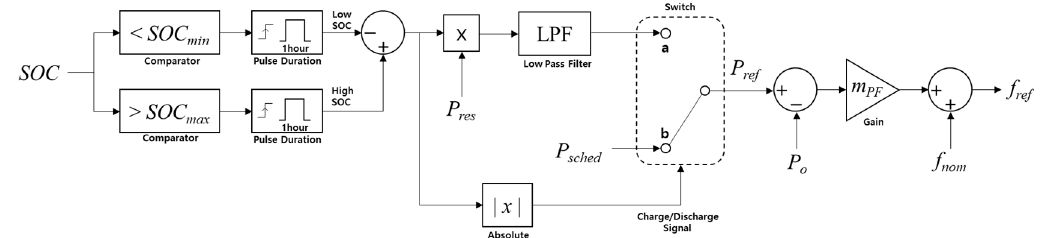
Figure 1. Proposed frequency reference controller for a droop-controlled grid-forming distributed generation (DG).